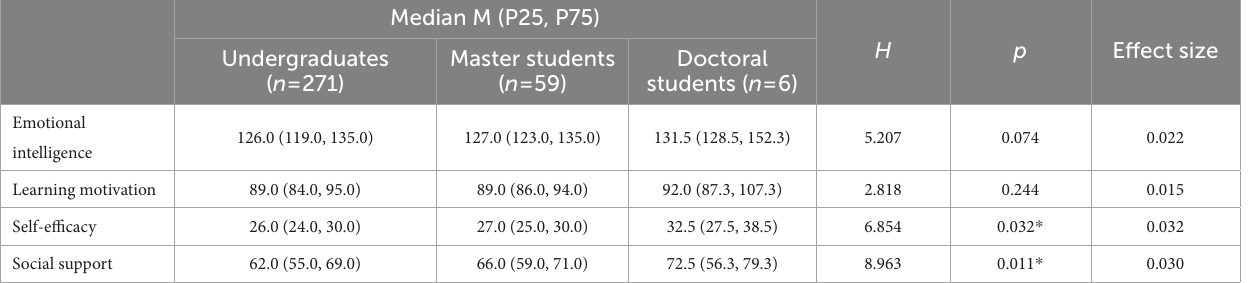
TABLE 6 Differences between different learning level